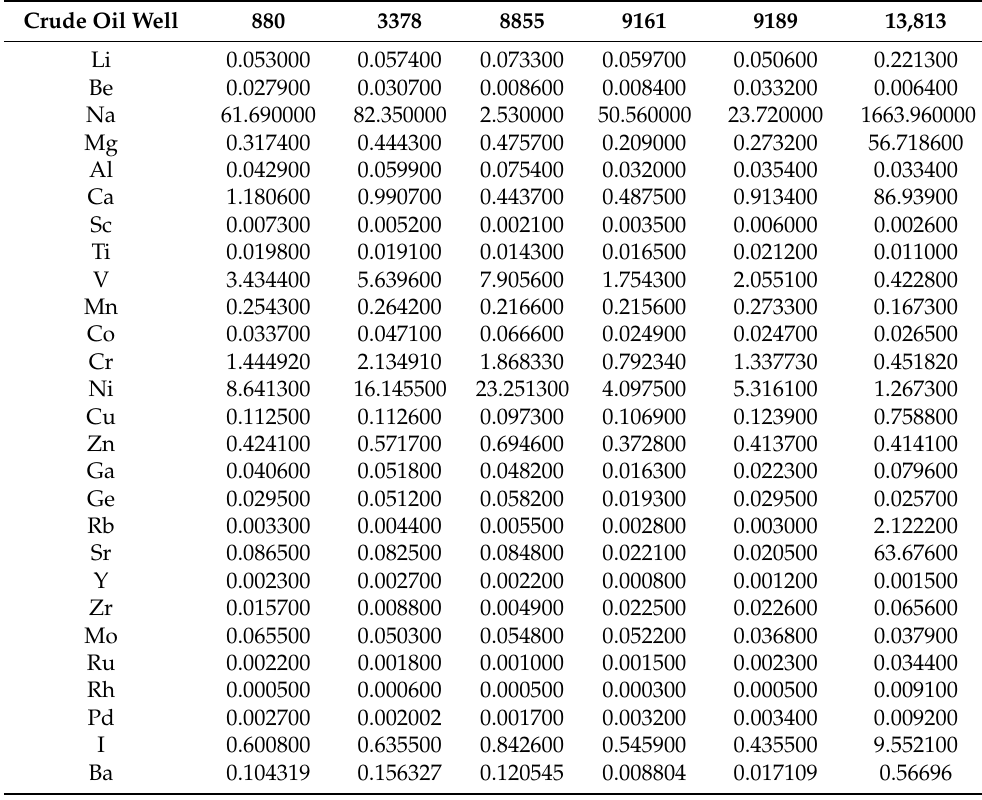
Table 3. Results of ICP-MS (in ppm) for crude oil of Abdrakhmanovskaya area (Romashkinskoye oil